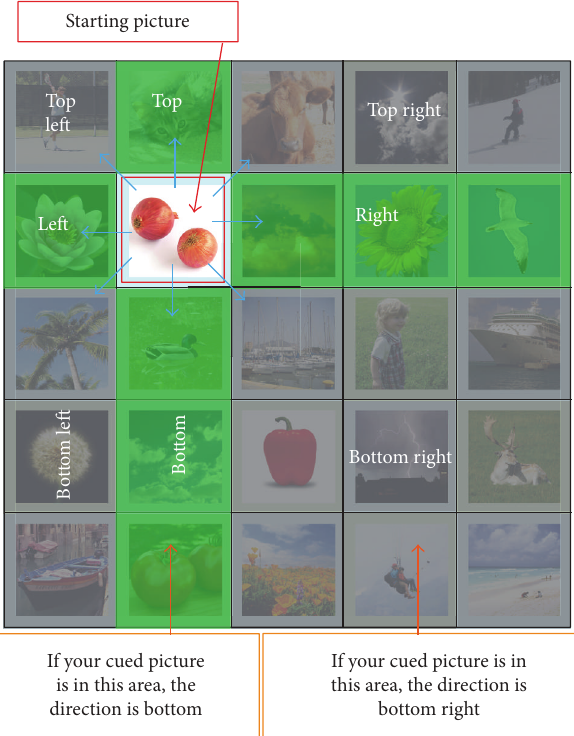
Figure 4: Directions obtained from the cued picture.